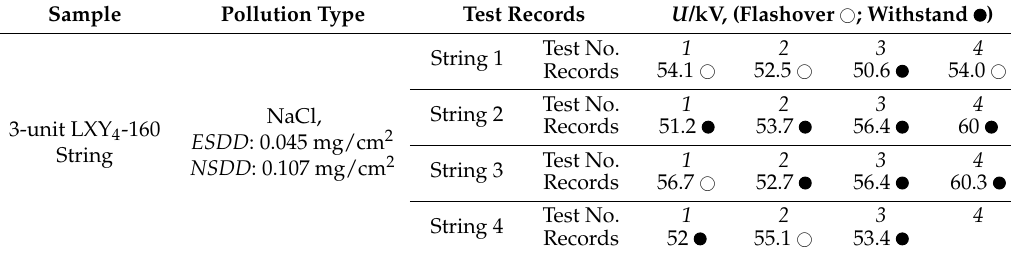
Figure 2. The diagram for the test procedure. Table 3. Example for the valid data record.